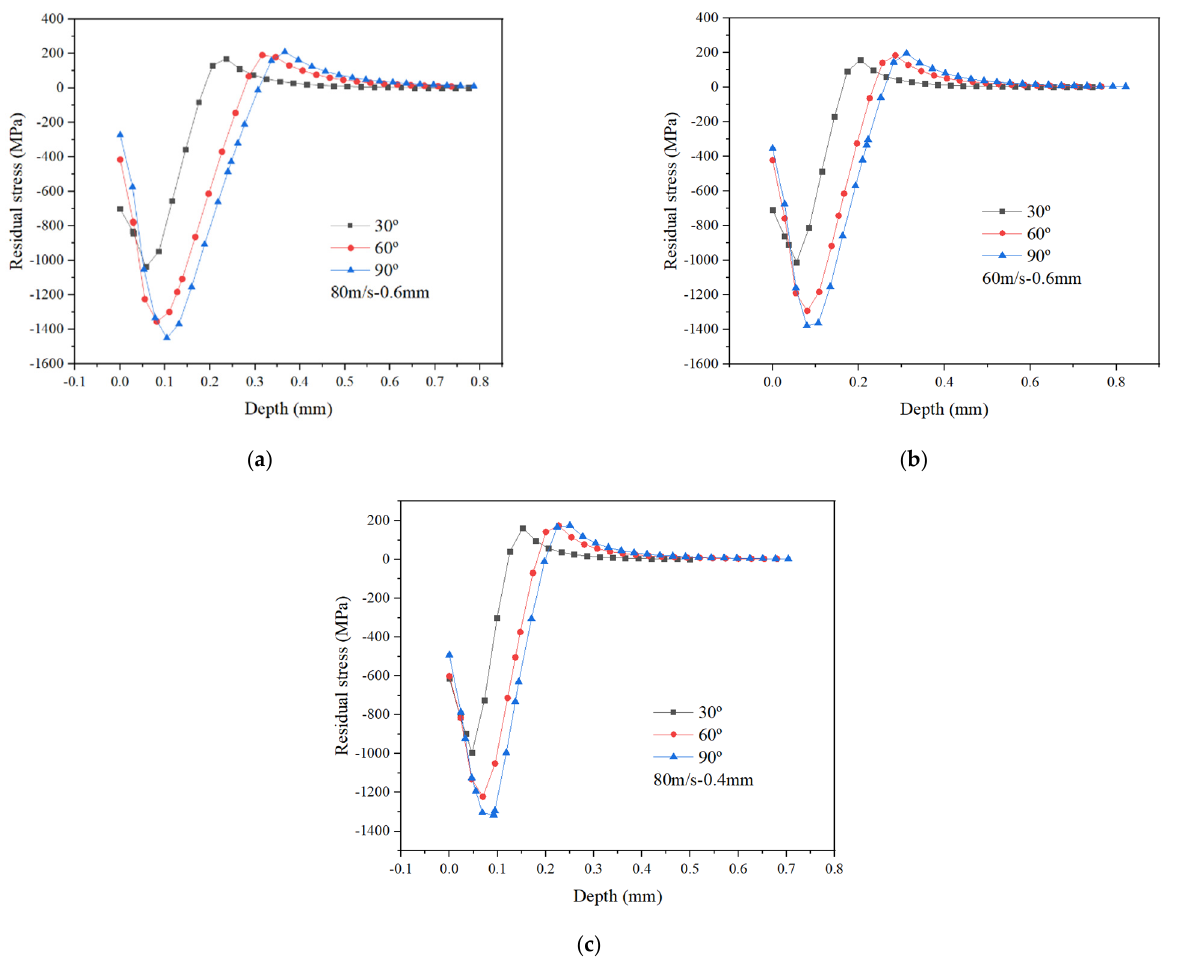
Figure 5. Effect of ball impact angle on residual stress under different processing parameters. ( a ) v p = 80 m/s and d p = 0.6 mm; ( b ) v p = 60 m/s and d p = 0.6 mm; ( c ) v p = 80 m/s and d p = 0.4 mm. Table 3. Original simulation results of residual